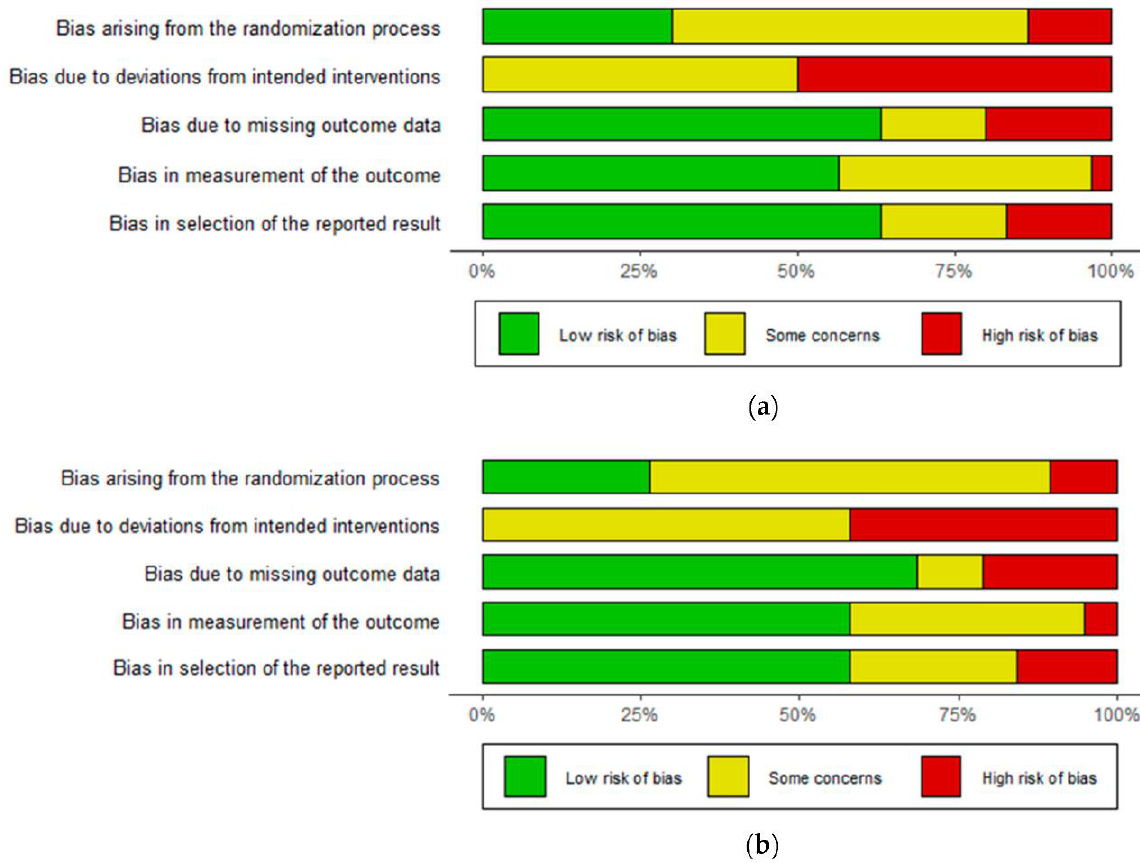
Figure 2. Summary of risk of bias. All studies, N = 33 ( a ), studies included into meta-analysis, N = 19 ( b ).